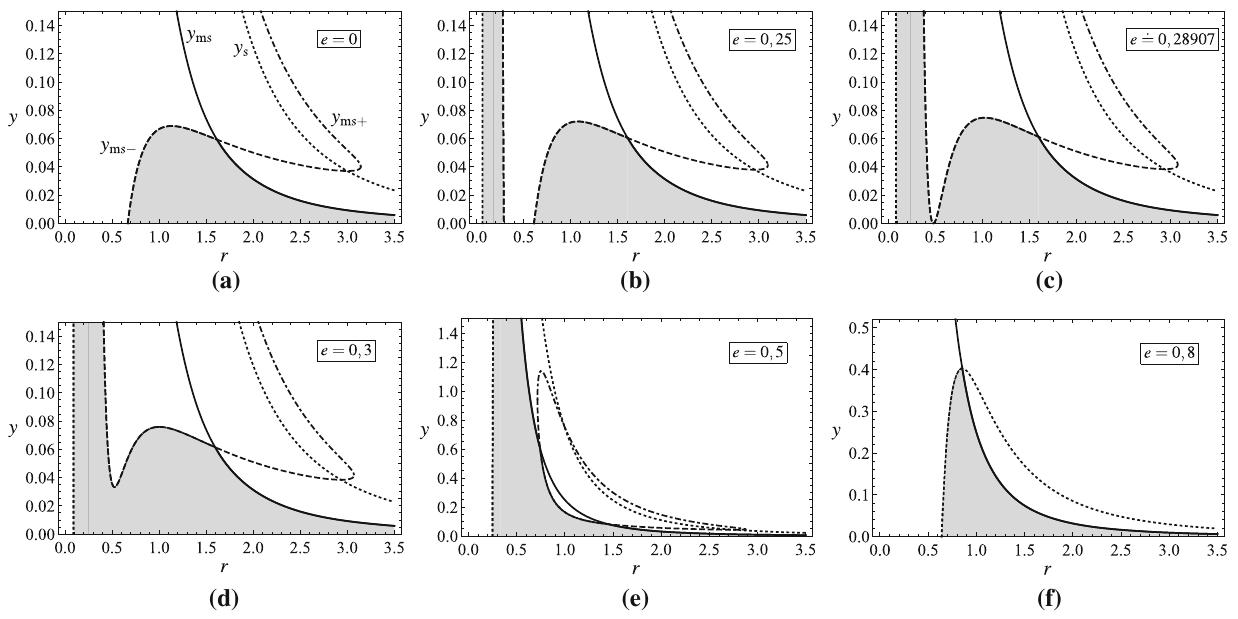
Fig. 6 Various forms of stability regions (shaded), enabling the exis- tence of stable equatorial circular orbits in the KNdS spacetimes, in dependence of a charge parameter e . The regions are given by common